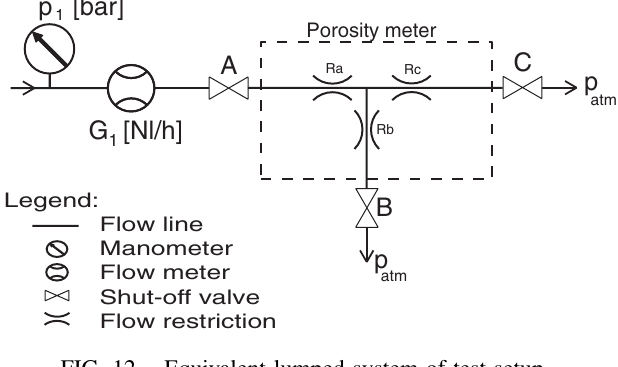
FIG. 12. Equivalent lumped system of test